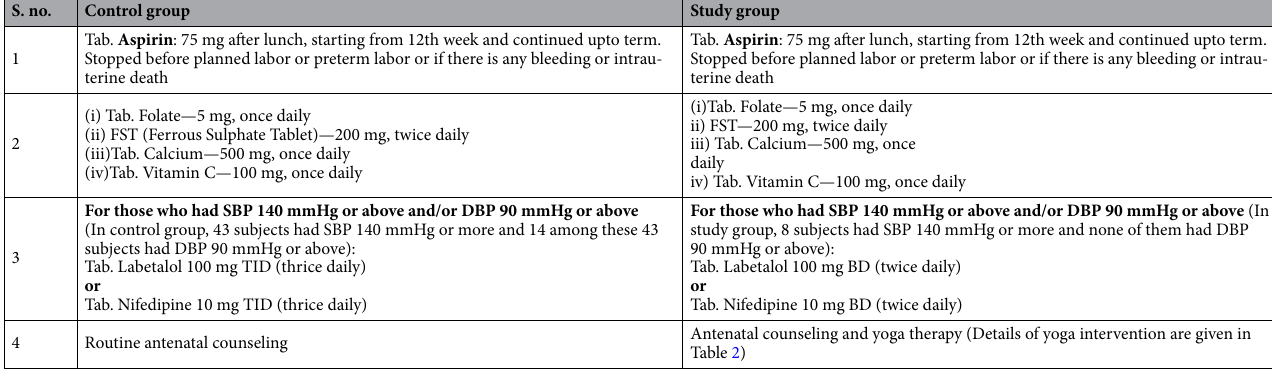
Table 1. Treatment received by pregnant women in control group and study